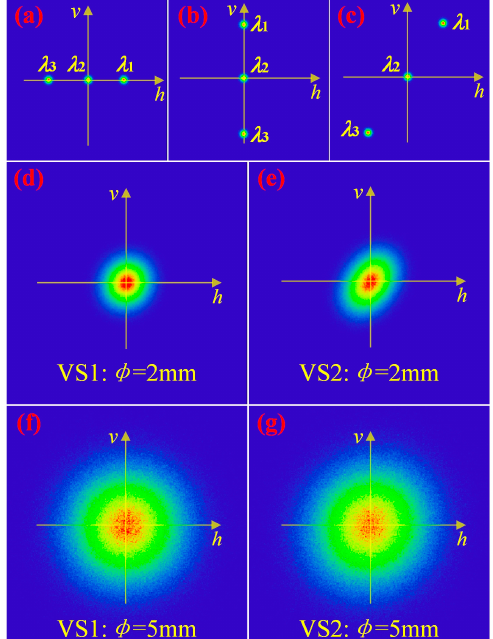
Figure 4. The spatial chirp of the output pulses induced by the stretcher misalignments. ( a ) The